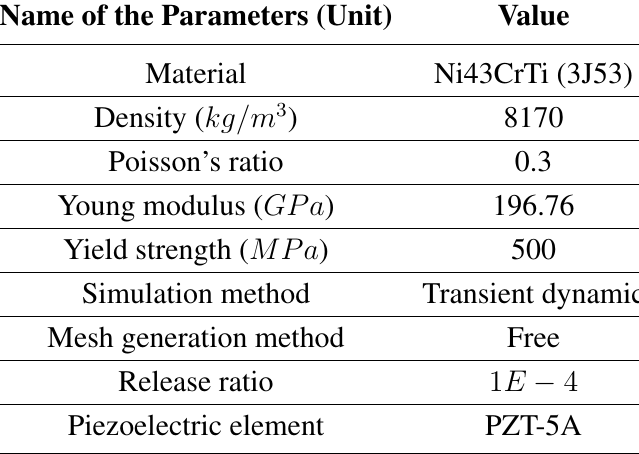
Table 1 . The parameters with